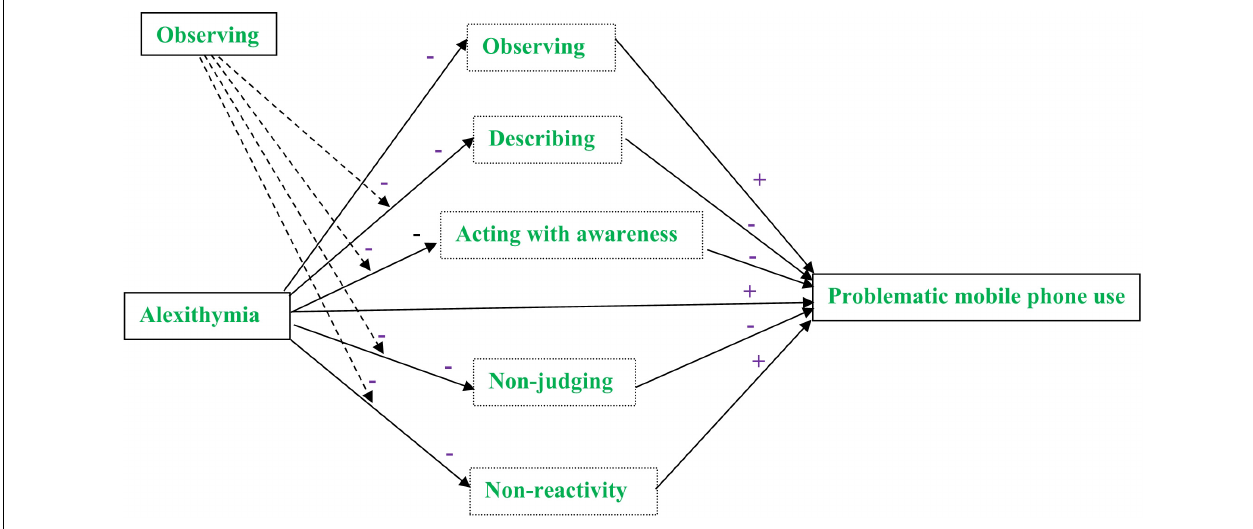
FIGURE 1 | The hypothesized model. The dotted boxes contained the investigated mediators and the dotted lines indicated the investigated moderation